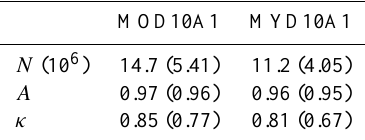
Table 5. Statistical measures of the comparison between MODIS products and Landsat, computed from the results presented in Ta- ble 4 ( N : sample size, A : overall accuracy, κ : kappa coefficient). The results for the forested areas are indicated in